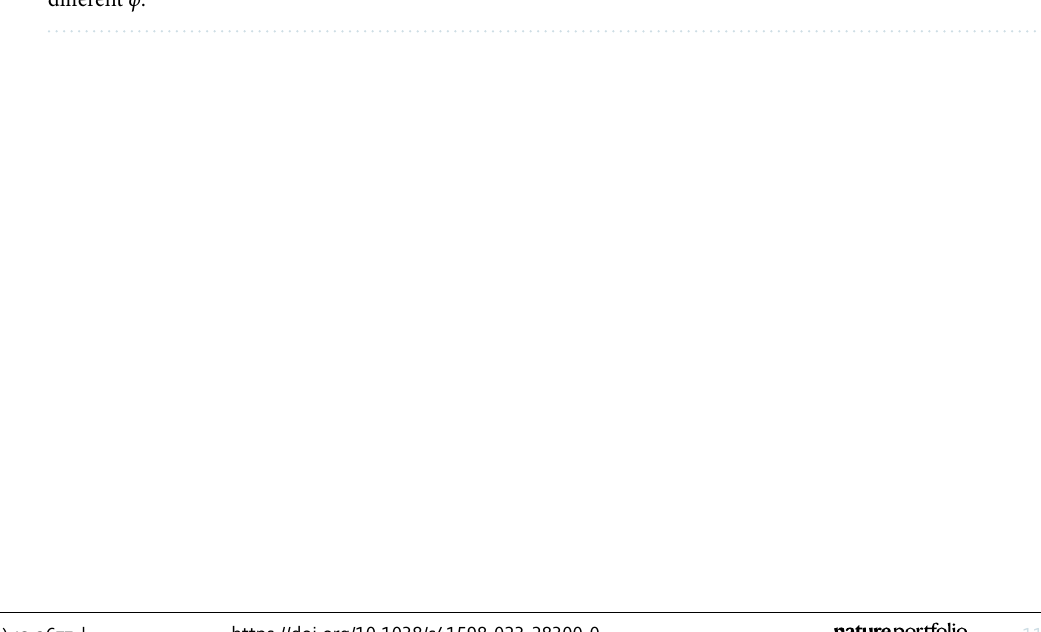
Figure 12. Streamlines at the mid chord of the blade show the fluid flow between the CG and top fence for different φ